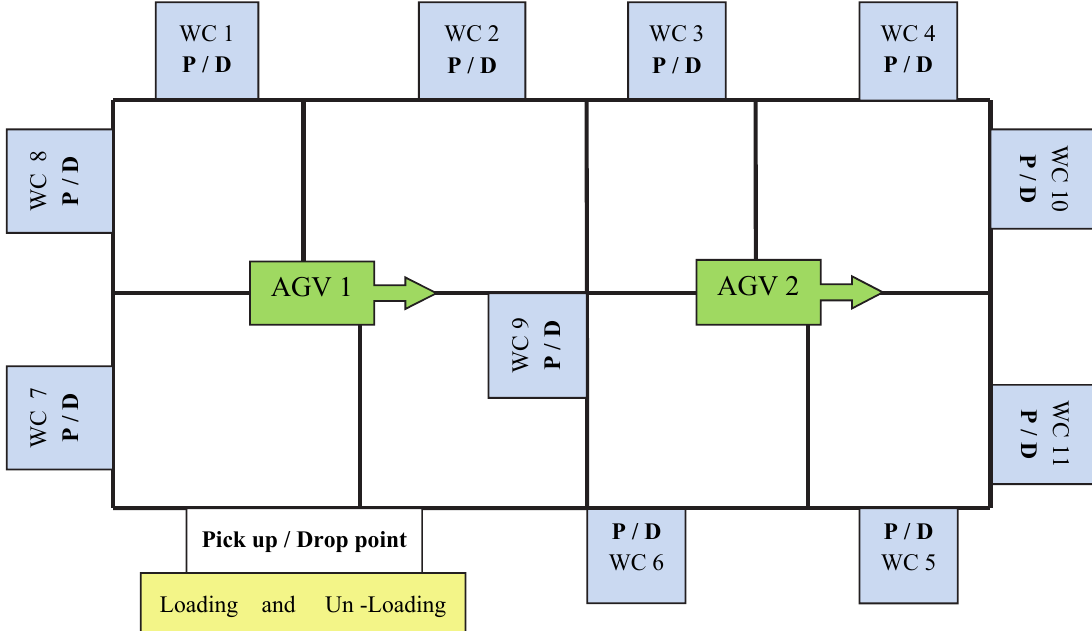
Fig. 5. The FMS layout 3 constituting 11 numbers of work center and one loading and unloading